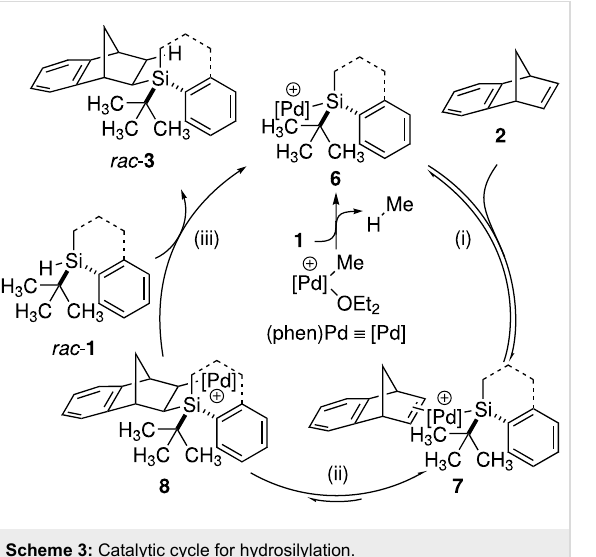
Scheme 3: Catalytic cycle for hydrosilylation.